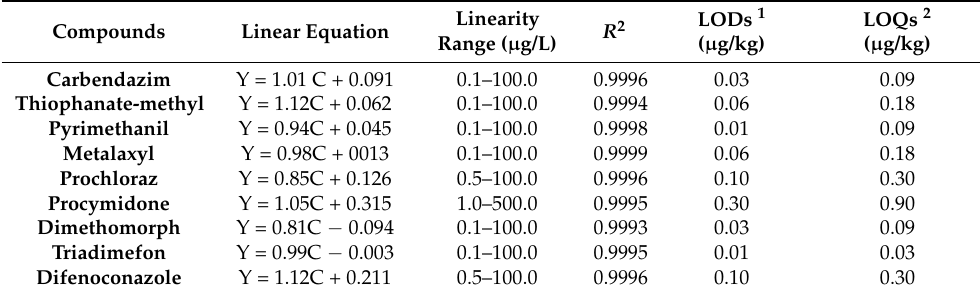
Table 3. Validation parameters obtained for the nine target fungicides in